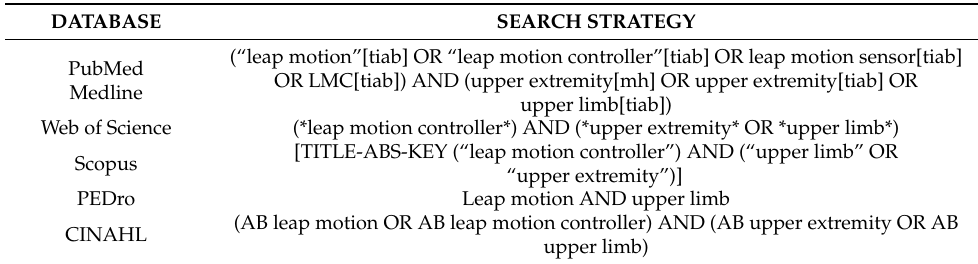
Table 1. Bibliographic search strategy used in each